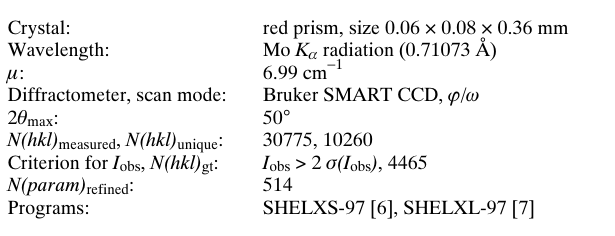
Table 1. Datacollection and